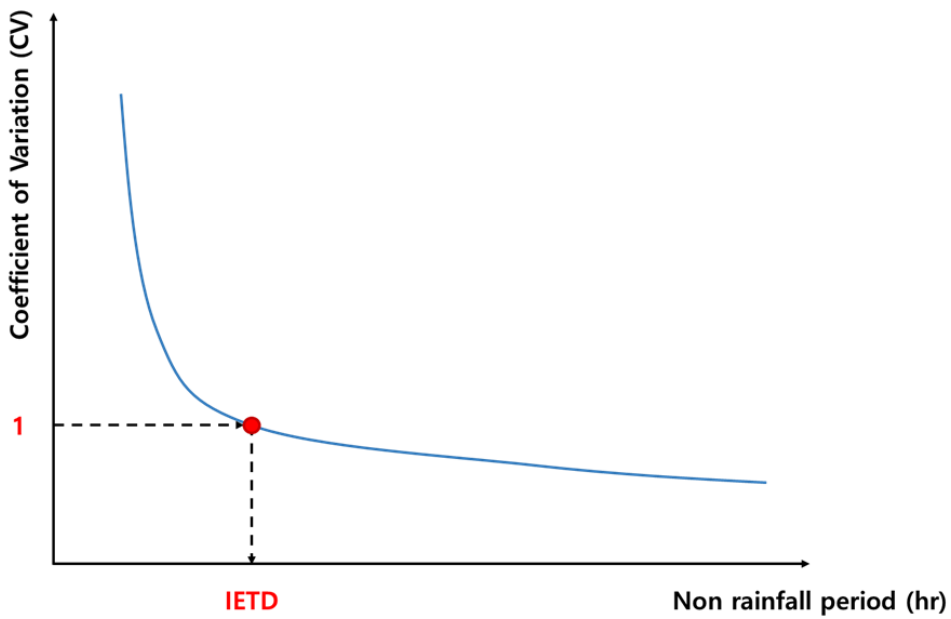
Figure 3. Coefficient of Variation (CV) method for calculating IETD; when the value of CV is 1, the corresponding y coordinate is the non-rainfall period, which is the IETD.